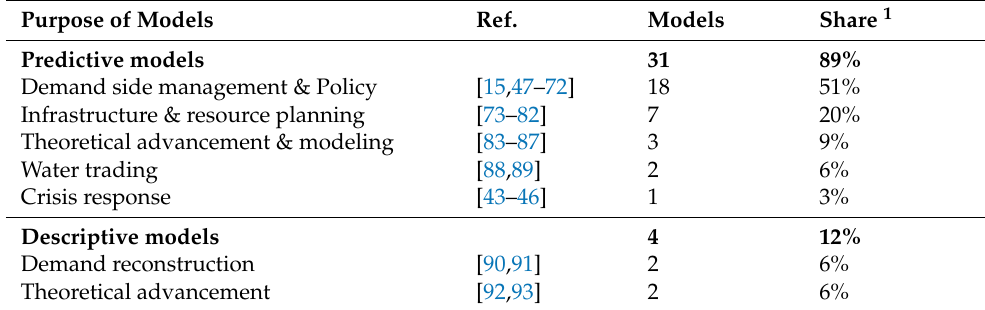
Purpose of Models